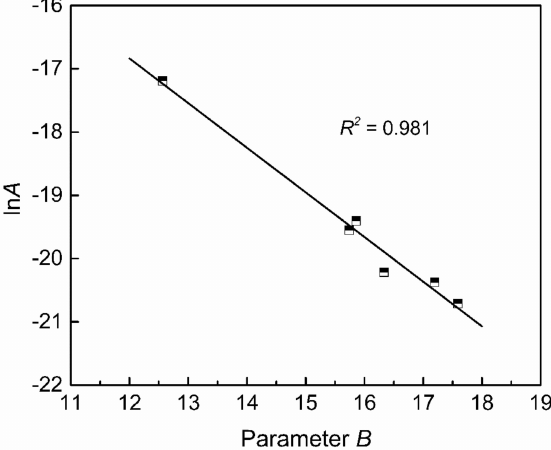
Figure 11. The relationship between parameters A and B